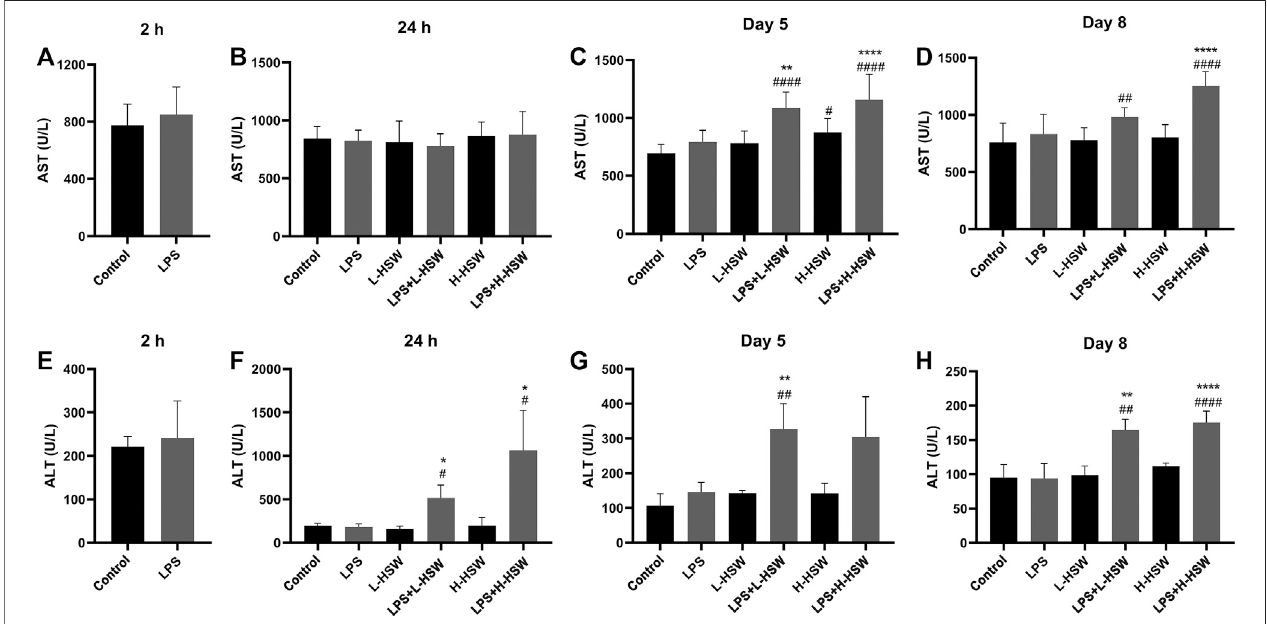
FIGURE2| HistogramsofserumALTandASTlevels.SerumASTandALTlevelsweredeterminedwithcorrespondingassaykits.Groupsofratsweretreatedwith saline (control), 2 mg/kg dose of LPS (LPS), 2 g/kg/day HSW (equivalent of raw herb, L-HSW), 10 g/kg/day HSW (equivalent of raw herb, H-HSW), 2 mg/kg LPS plus 2 g/kg/dayHSW(LPS+L-HSW),and2 mg/kgLPSplus10 g/kg/dayHSW(LPS+H-HSW),respectively. (A) to (D) showedtheASTlevelsat2 h,24 h,day5andday8, respectively; (E) to (H) showed the ALT levels at 2 h, 24 h, day 5 and day 8, respectively. Each bar represents the mean ± standard error ( n (cid:2) 6). # p < 0.05, ## p < 0.01, ### p < 0.001, and #### p < 0.0001 comparing with control group. * p < 0.05, ** p < 0.01, *** p < 0.001, and **** p < 0.0001 comparing with LPS